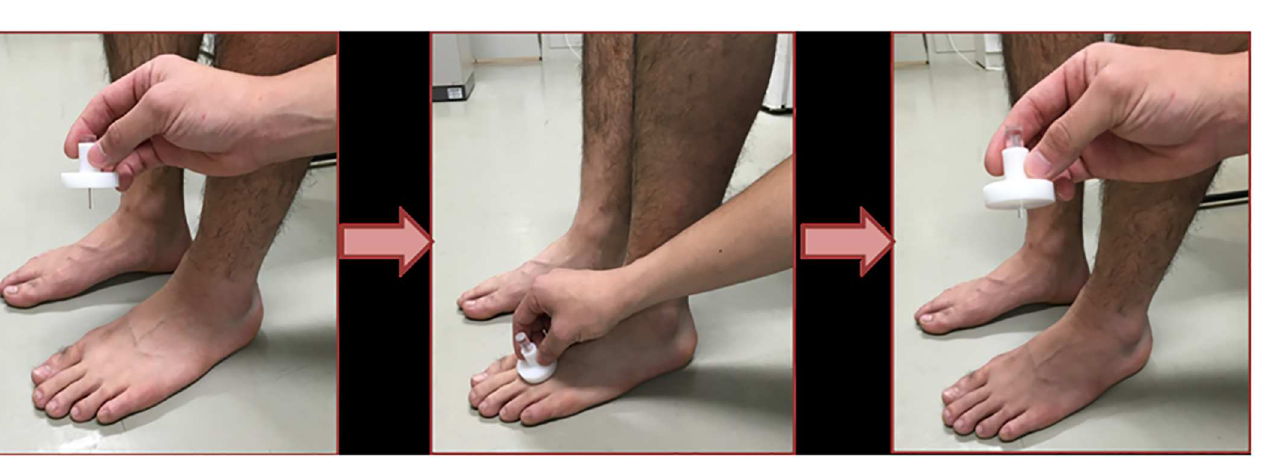
Fig 3. Visualization process of the instrument for the